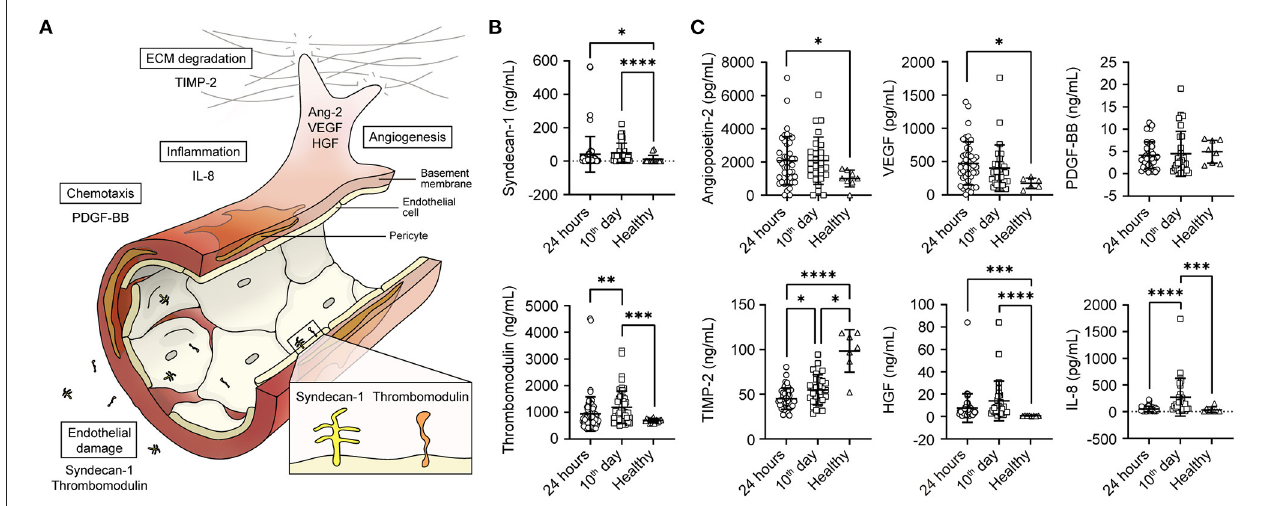
FIGURE 1 | Serum levels of endothelial damage and angiogenesis-related proteins. (A) Summary of key molecules involved in angiogenesis and endothelial damage. (B) Graph representing the mean serum of syndecan-1 and thrombomodulin during the first 24h of hospitalisation ( n = 43), after 10 days ( n = 28) and in healthy individuals ( n = 9). (C) Graph representing the mean serum of angiopoietin-2, TIMP-2. VEGF, PDGF-BB, HGF, and IL-8. Statistical significance ( P -values) is obtained using two-sided Kruskal–Wallis with Dunn’s multiple comparison test, * P < 0.05; ** P < 0.01; *** P < 0.001. **** P < 0.0001.